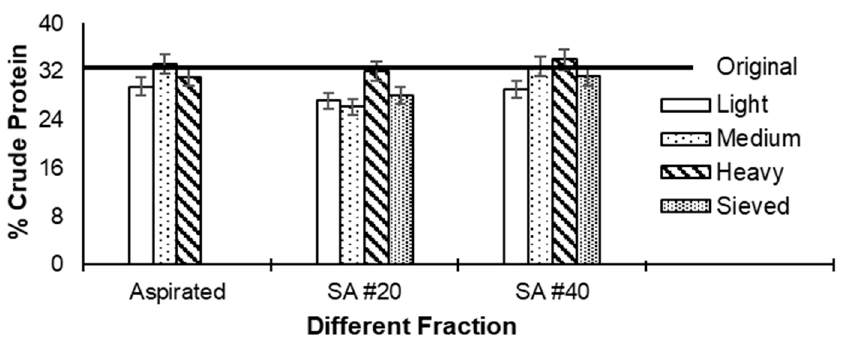
Figure 3. Crude protein variation of the different fractions.